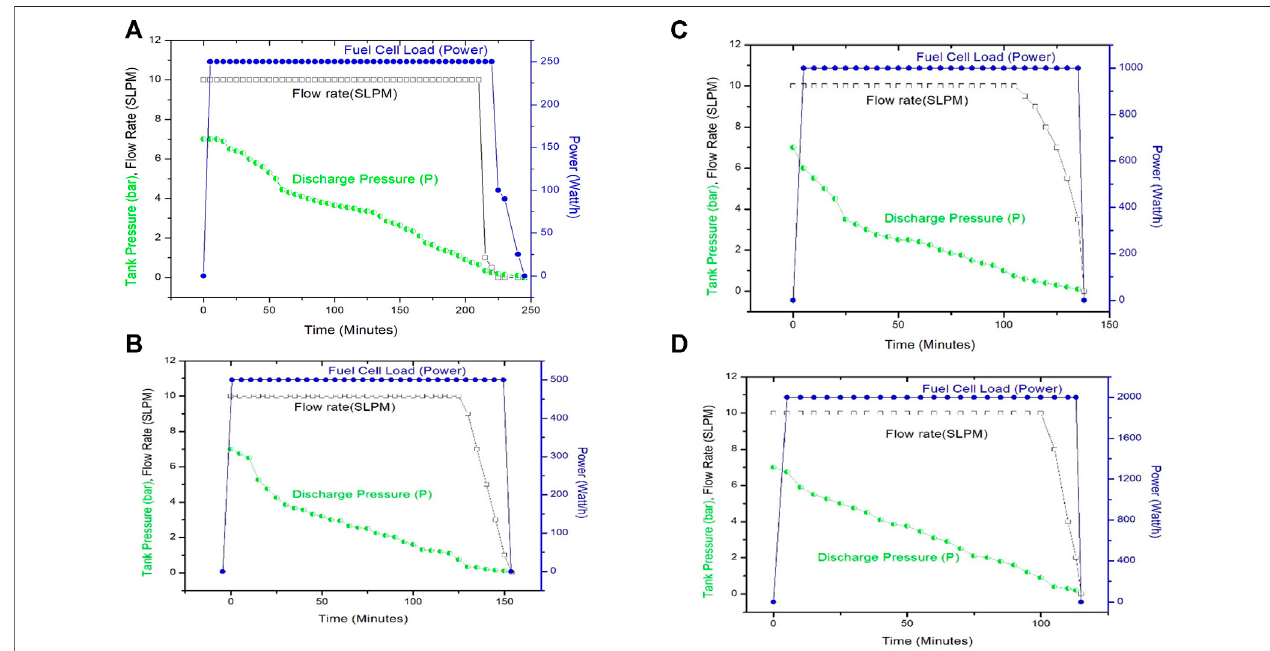
FIGURE 8 | Discharge characteristics of MH tank 2 at different loads of (A) 250 W and (B) 500 W.